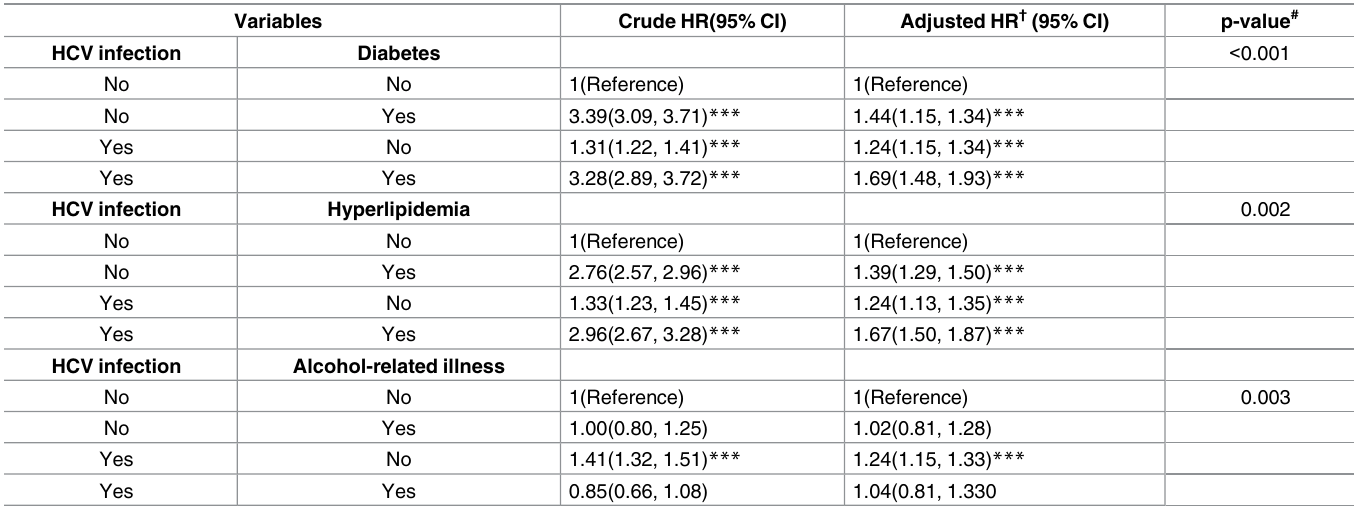
Table 5. Cox method estimated hazard ratios of cataractassociated HCV infection and comorbidity. Variables